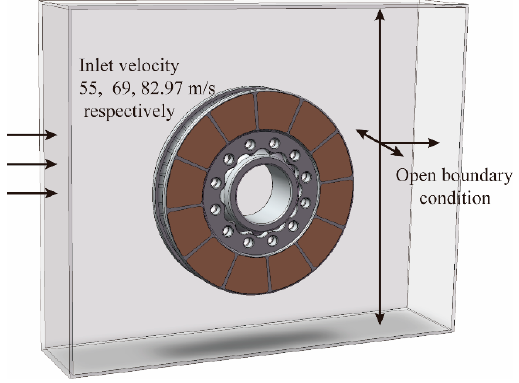
Figure 3. Computational fluid dynamic (CFD) model for air convection calculation.